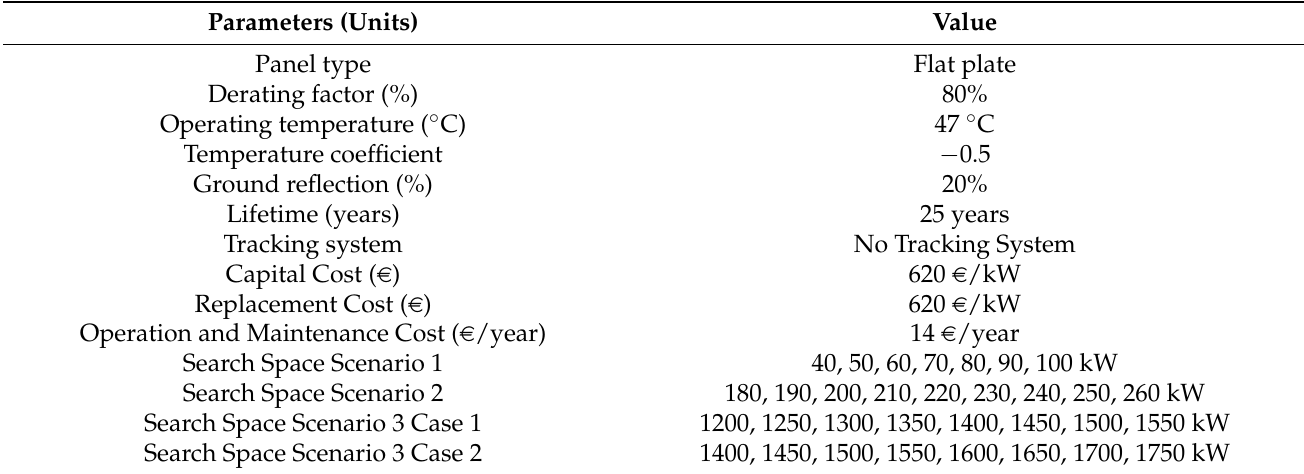
Table 4. PV technical speciifications and